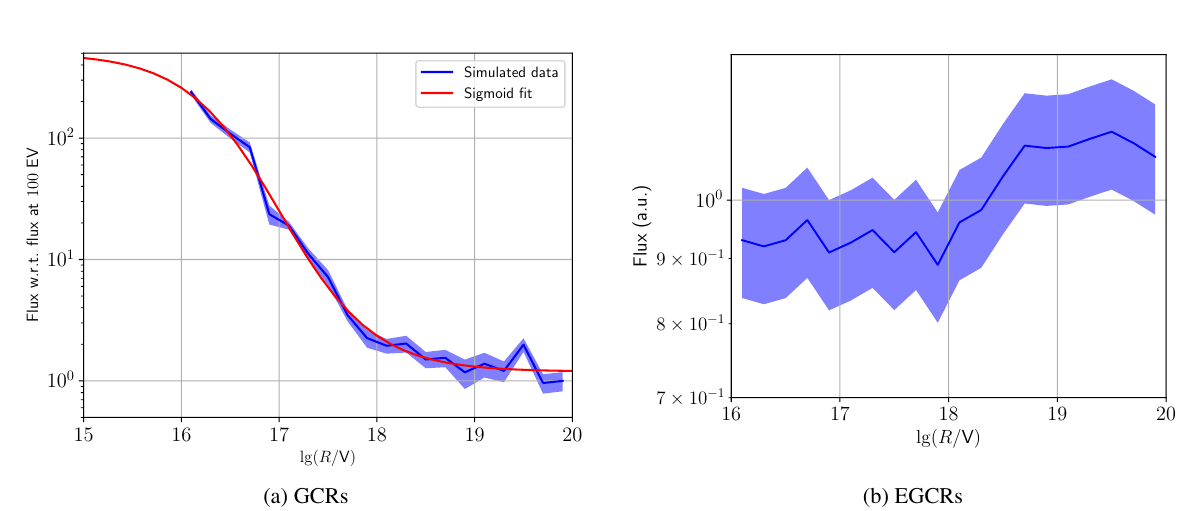
Figure 6: Rigidity spectra indicating the flux modifications imposed by the